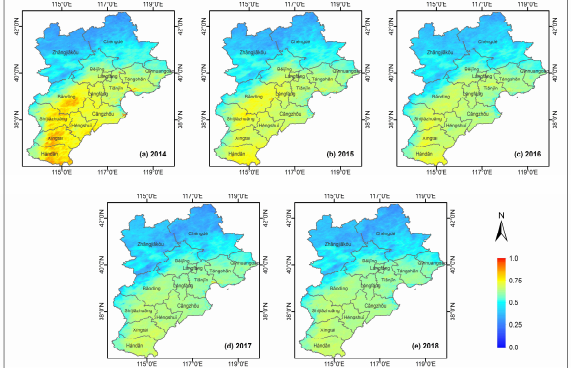
Figure 7. Spatial distribution of AOD annual averages in BTH region from 2014 to 2018